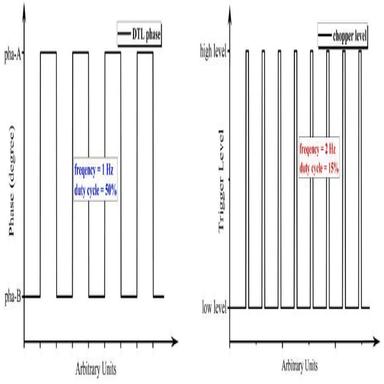
Frequency and phase relationship between trigger signals of different components.